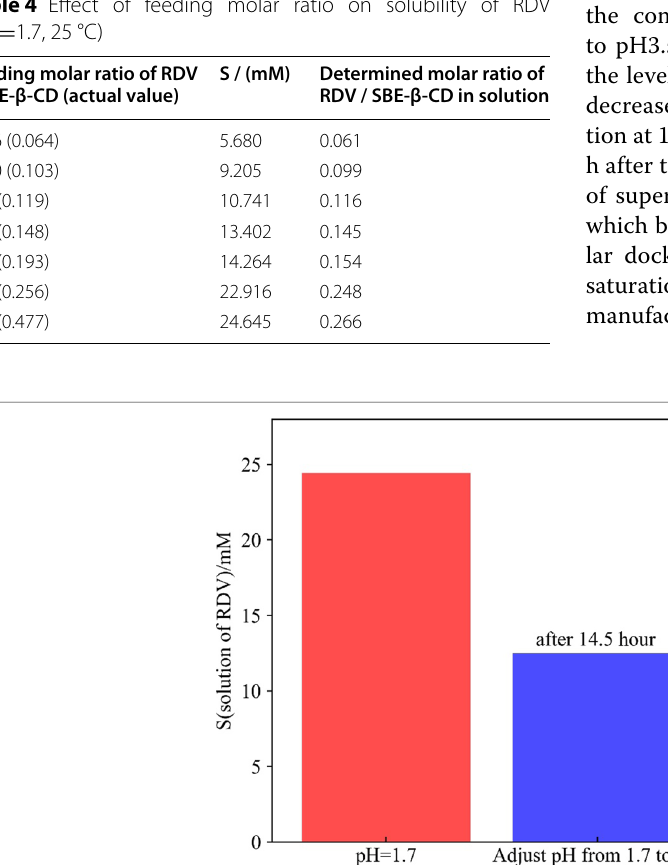
Table 4 Effect of feeding molar ratio on solubility of RDV